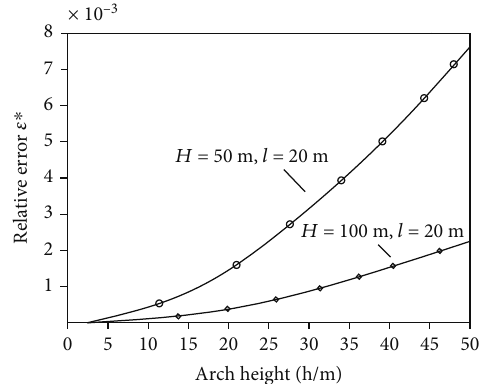
Figure 7: Relationship lines between ε ∗ and h .